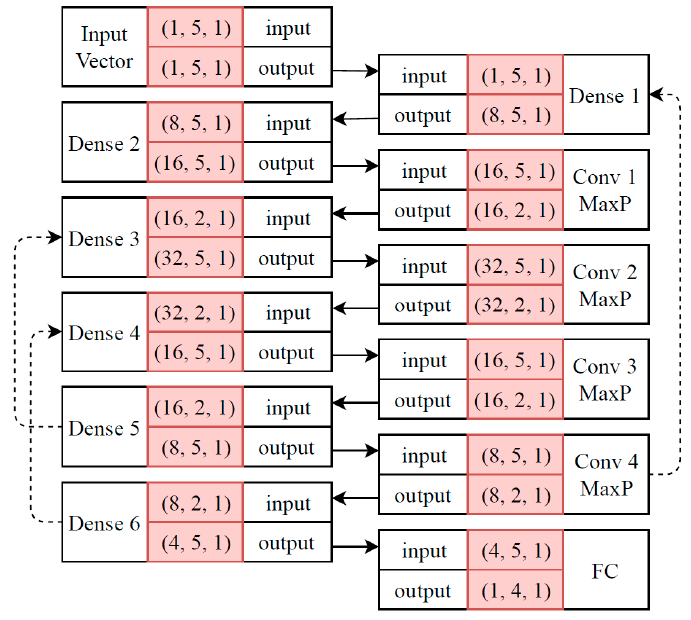
Figure 4. Proposed recurrent CNN (RNN) architecture for the ATRP.